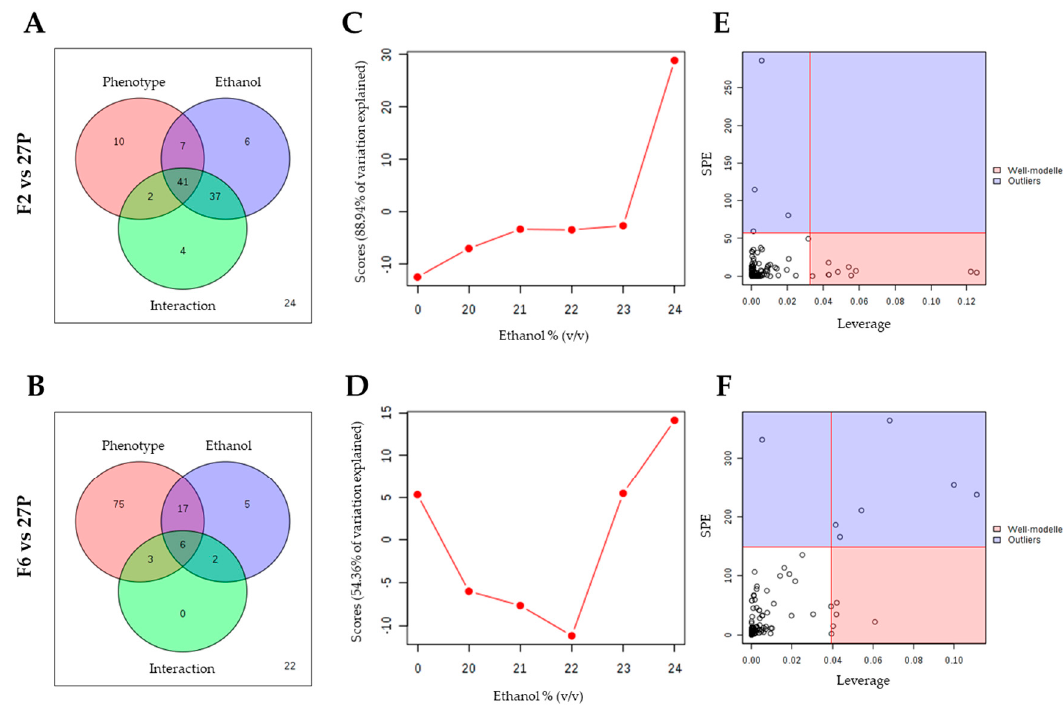
Figure 3. Two-way ANOVA ( A , B ) and ANOVA-Simultaneous Component Analysis (ASCA) ( C - F ) on metabolites produced by yeast cells (F2 vs . 27P and F6 vs . 27P) exposed to increasing ethanol concentrations (0%, 20%, 21%, 22%, 23%, 24 %, v / v). Legend. Venn diagram of metabolites a ff ected by ethanol concentration, strain and their interaction (A,B). Major pattern of metabolites associated with ethanol concentration (C,D). ANOVA-Simultaneous Component Analysis (ASCA) selection of important metabolites associated with ethanol concentration by Leverage / SPE analysis (E,F). Ten and four metabolites were identified as responsible for the observed variation in the comparison between parental and recombinants F2 (E) and F6 (F), respectively.